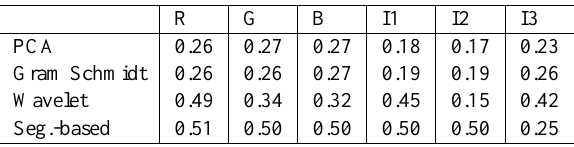
Table 3: Universal Quality Index according to (Wang and Bovik 2002) for different channels of the pansharpened images